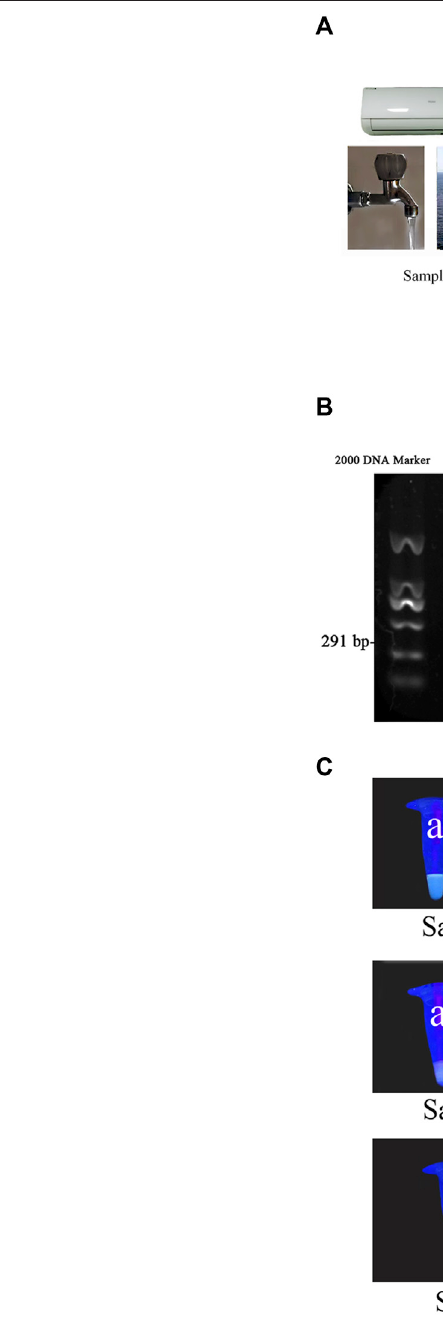
Frontiers in Chemistry |